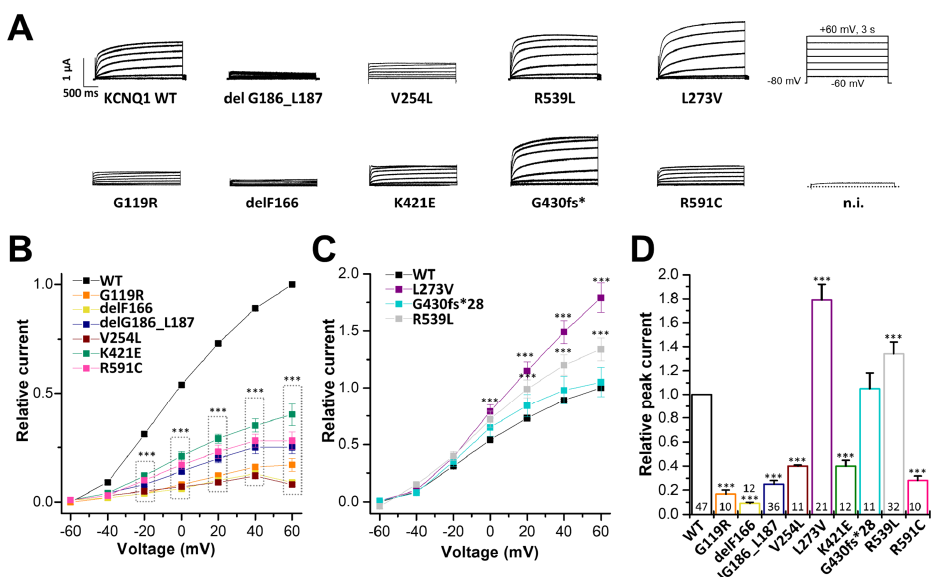
Figure 3. Electrophysiological properties of nine KCNQ1 variants. ( A ) Representative current traces of wild-type KCNQ1 and the KCNQ1 variants after heterologous expression in Xenopus laevis oocytes (14.5 ng cRNA/oocyte). Voltage was clamped to potentials ranging from − 60 to +60 mV in 20 mV increments, with steps of 3 s durations (the voltage protocol is illustrated on the right). n.i., current trace of non-injected oocytes at a voltage step from − 80 to +60 mV. ( B ) Current-voltage relationships of variants with significantly reduced current amplitudes compared to wild-type KCNQ1. Current- voltage relationships (I/V curves) were obtained by analyzing the current amplitude at the end of each voltage step, normalized to the current of wild-type KCNQ1 channels at +60 mV. Note that all data were normalized to the currents recorded for the wild-type channels at +60 mV of the respective recording day. ( C ) Current-voltage relationships of variants with significantly increased current amplitudes and variants without changes in the current amplitudes. ( D ) Current amplitudes analyzed at +40 mV (normalized to the amplitudes of wild-type KCNQ1 (WT)). All the data, including that of the wild-type recordings, were divided by the average current amplitude of the wild-type at +40 mV of the respective recording day. The current amplitude of non-injected oocytes at +40 mV was about 150 nA. Numbers of oocytes recorded are indicated within the bar graphs. Values are expressed as means ± S.E.M. Error bars represent S.E.M. values. Significance was assessed using two-tailed Student’s t -test. Asterisks indicate significance: ***, p <